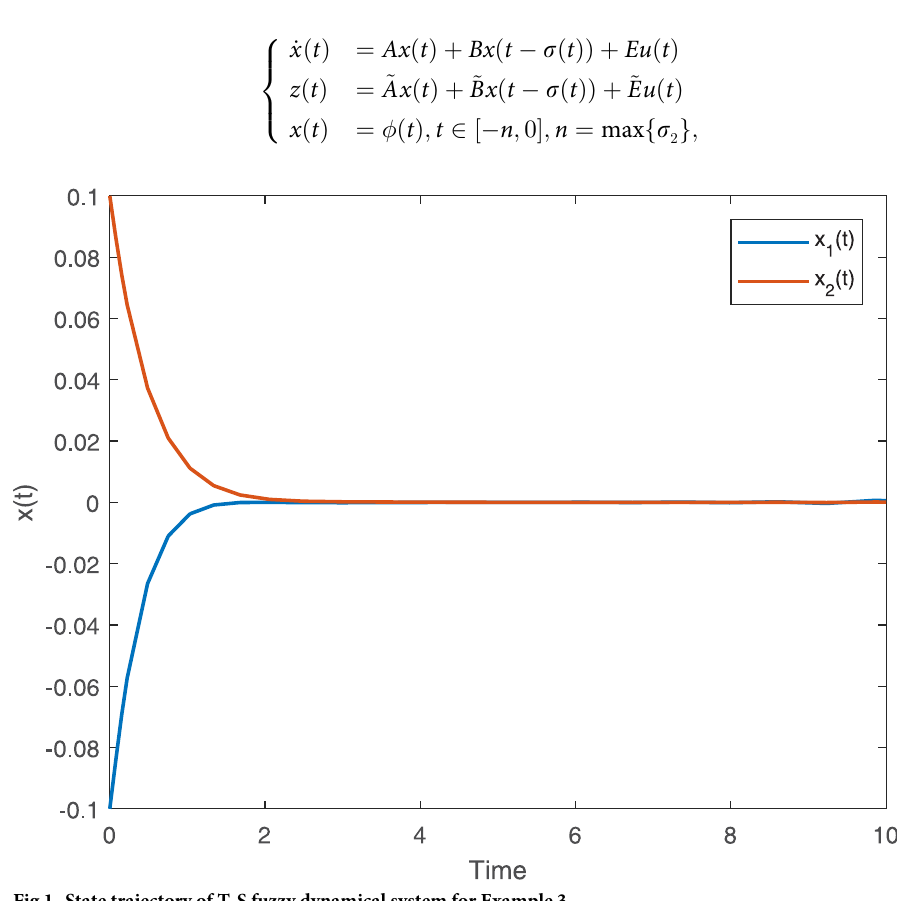
Fig 1. State trajectory of T-S fuzzy dynamical system for Example